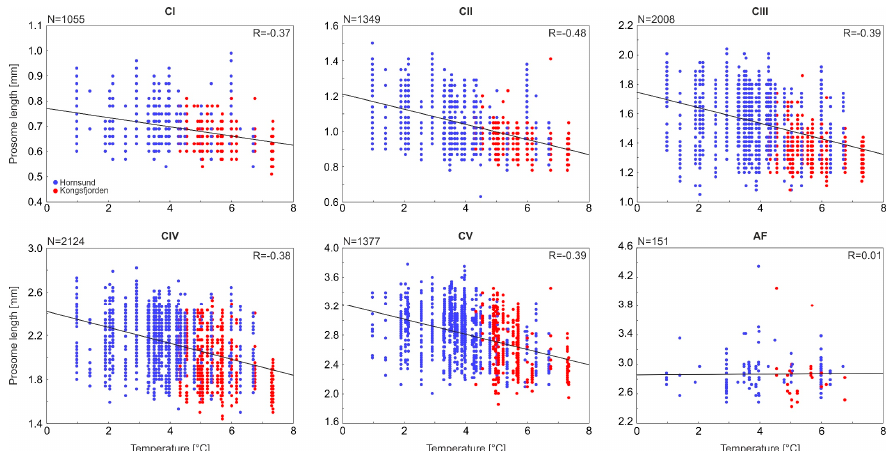
Figure 3. The relation between seawater temperature and prosome length of Calanus copepodite stages CI–AF. Dots represent individuals measured, blue in Hornsund and red in Kongsfjorden. Trendline is marked in black, N indicates the number of measured individuals, R indicates Pearson correlation coefficient.